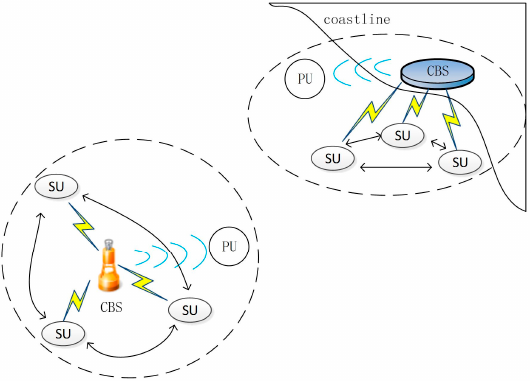
Figure 1. Centralized maritime cognitive radio communication system.